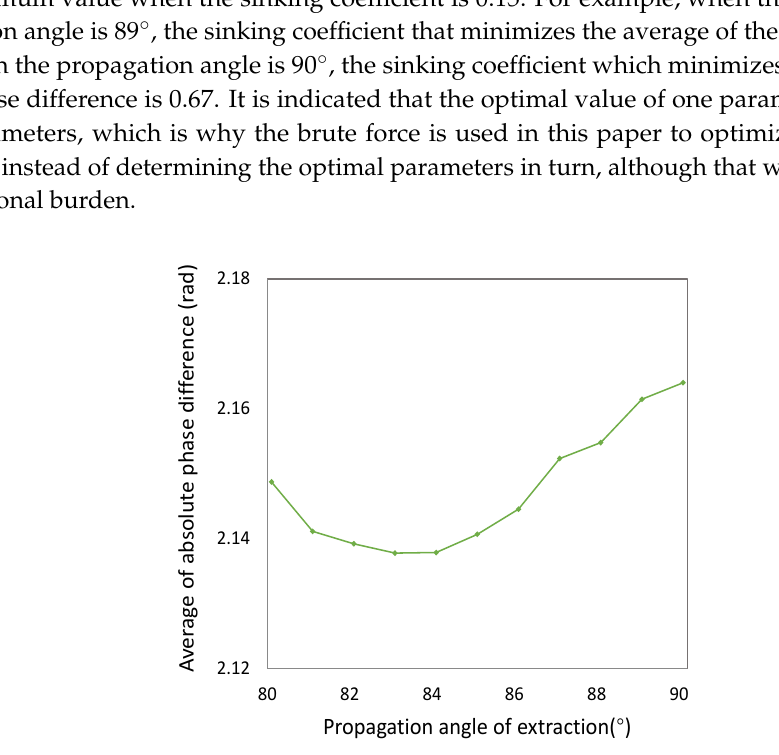
Figure 9. Relationship between phase difference and propagation angle of